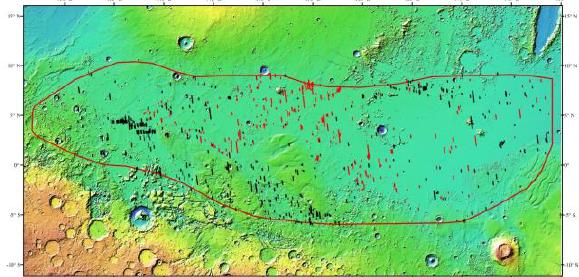
Figure 4. Distribution of PRP terrain in Elysium Planitia. The footprints of the HiRISE images wherein the PRP terrain exists are shown in red while others are shown in